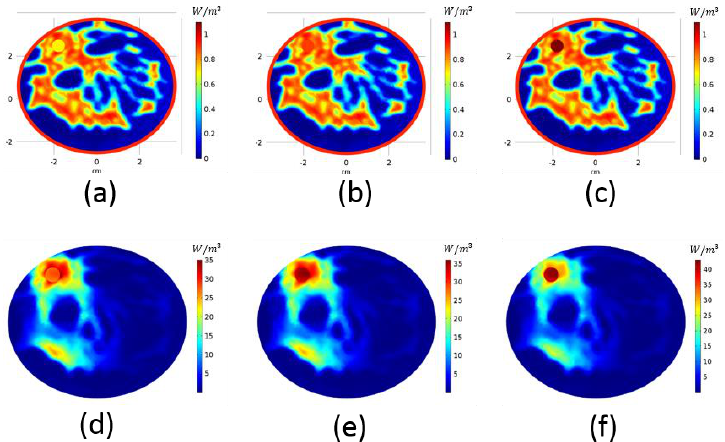
Figure 5. Electrical conductivity map of breast model-I with tumor of ( a ) 0.7 S/m, ( b ) 0.9 S/m and ( c ) 1.1 S/m. Heating potential distribution of breast model-I with tumor of ( d ) 0.7 S/m, ( e ) 0.9 S/m and ( f ) 1.1 S/m.